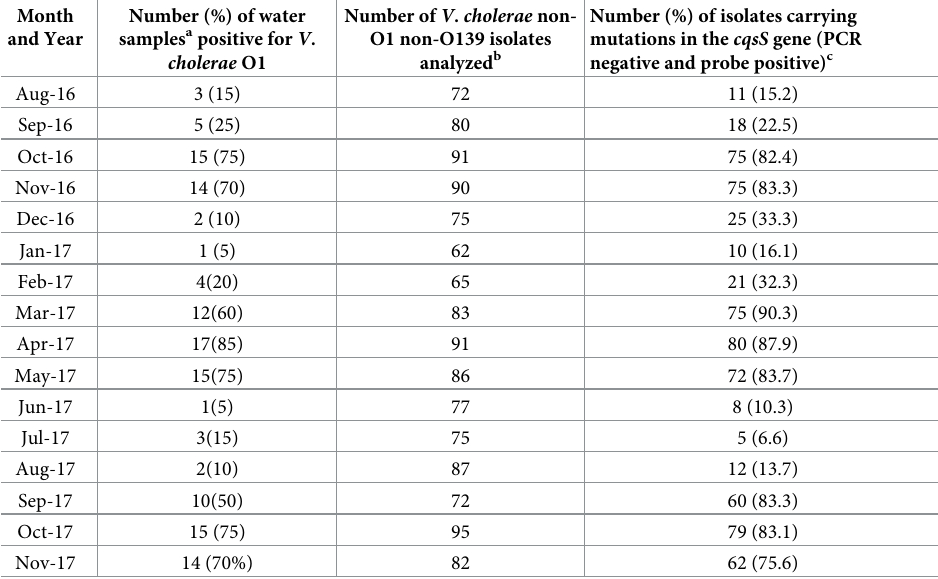
Table 3. Co-occurrence of Vibrio cholerae non-O1 non-O139 strains carrying defined mutations in the cqsS gene and overproducing AI-2 with toxigenic V . cholerae O1 in surface water samples in Bangladesh d . Month Number (%) of water Number of V . cholerae non- and Year samples a positive for V . O1 non-O139 isolates analyzed cholerae O1